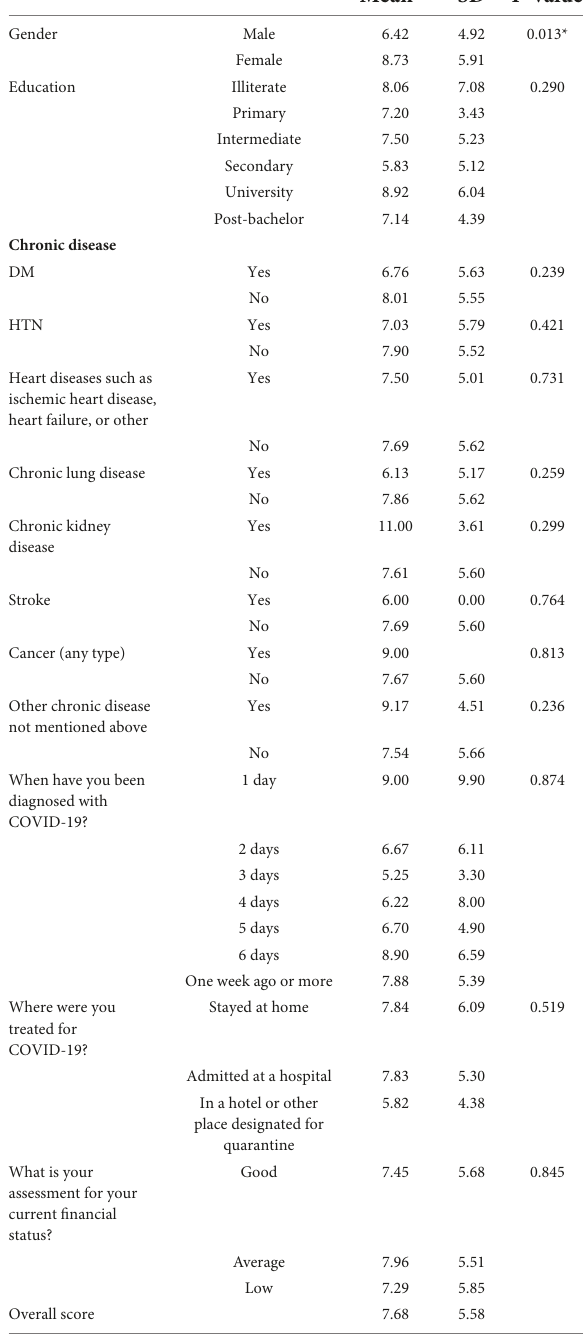
TABLE 4 Mean score of PHQ-9 depression questionnaire for confirmed patients with COVID-19 by their